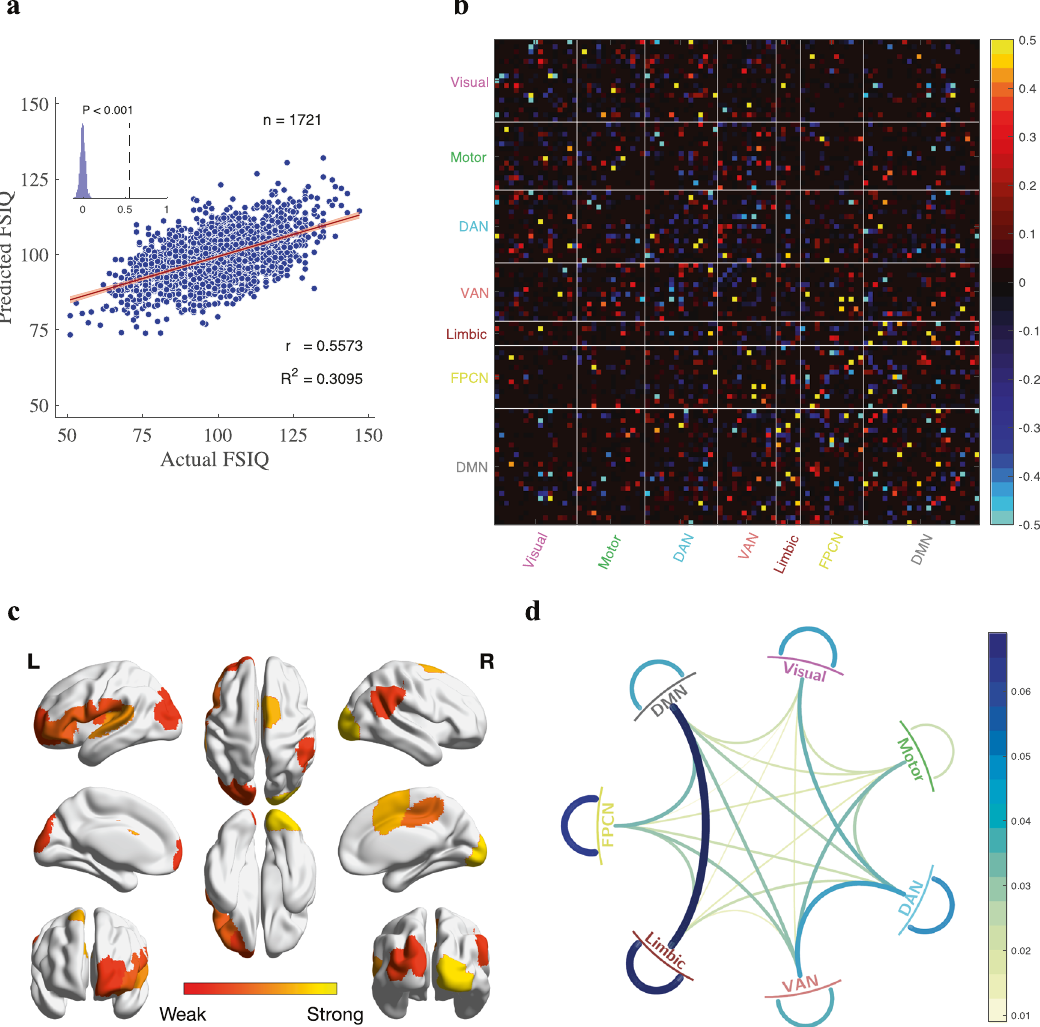
Fig. 2 Transdiagnostic connectome signatures predictive for individual FSIQ. a FSIQ prediction model on transdiagnostic population. The model is evaluated by 10x fi ve-fold cross-validation. The inset displays the null distribution of model performance by permutation testing with 1000 permutations. Dashed line indicates actual performance. Error bar shows standard deviation. This model is hereafter referred to as the “ standard model ’ . b Edge-wise importance of functional brain connections with respect to FSIQ. Each cell represents the edge-wise importance derived by averaging feature weights of FSIQ prediction models for each of cross-validation folds. Red/blue cells indicate positive/ negative feature weights of brain connection with respect to FSIQ. c ROI importance with respect to FSIQ. ROI importance is derived by averaging the absolute feature weights of all functional brain connections involving an ROI. The top 10 important ROIs are shown for clarity. d Importance of functional brain connections at the network level. The importance of functional brain connections between two networks/ within a network is de fi ned by the average of absolute feature weights of all functional brain connections residing between those two networks/within the network of entire transdiagnostic population (Visual: Fisher ’ s z = 2.73, We further evaluated the importance of each brain network on predicting FSIQ for the entire transdiagnostic population as well as each diagnosis group by removing all functional connections involved in the brain network of interest from the prediction model. Resultant leave-one-network-out models were still pre- dictive of FSIQ (Fig. 3, bottom table), which supported the idea that the broad concept of intelligence measured with a standardized instrument and a variety of subtests is distributively embedded across the brain thus enabling us to perform quantitative analysis on network importance. We de fi ned the importance of a brain network as the decrease in the predictability of the network-removed prediction model compared with the model with the full connectome (Fig. 3). A set of Fisher ’ s z-tests Table 2. Together, these observations demonstrate diagnosis- comparing leave-brain-network-out models with the standard speci fi c contributions of each brain network to intelligence, model identi fi ed brain networks with signi fi cant importance to the informing the association between identi fi ed transdiagnostic